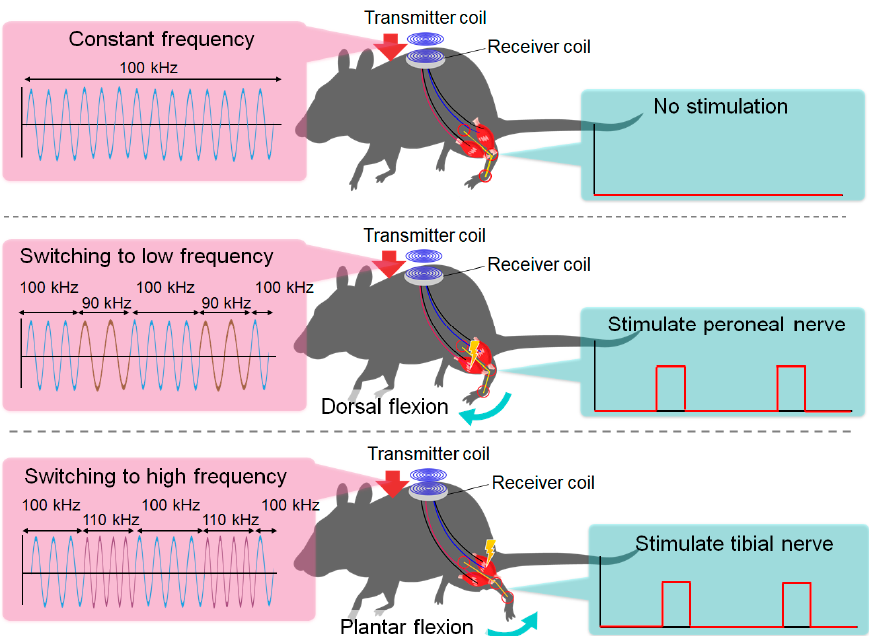
Figure 2. A schematic indicating the selective stimulation of the rat peroneal and tibial nerves by switching the transmitter frequency.